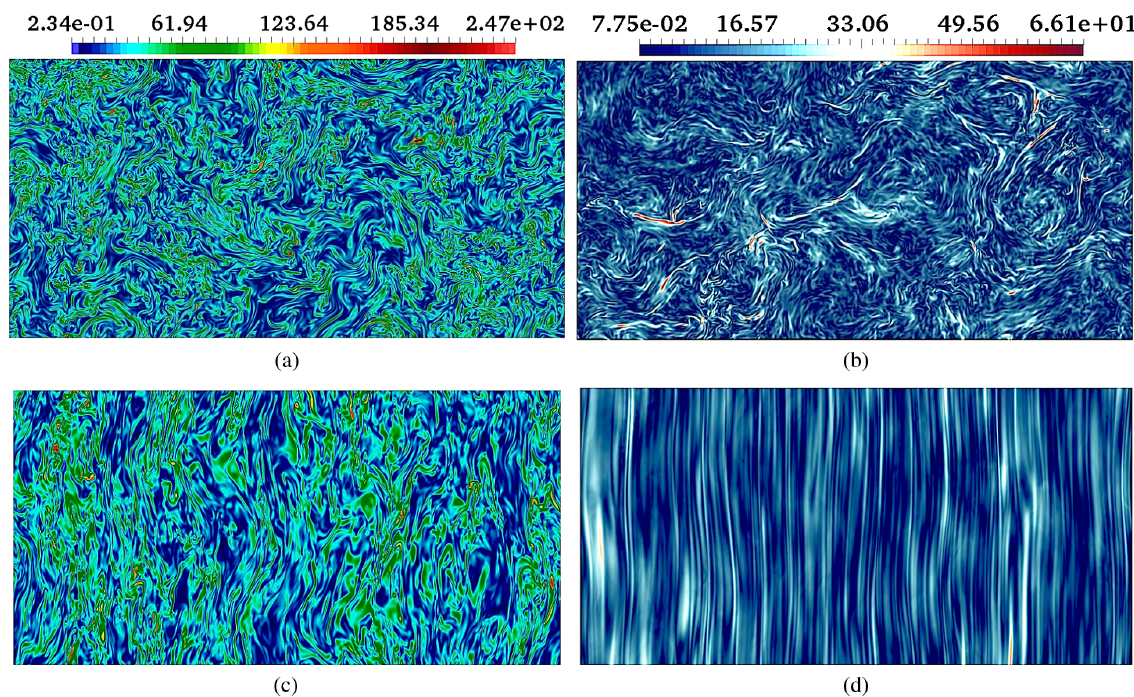
FIG. 4. Amplitude of vorticity (left panels) and current density (right panels) fluctuations in a field-perpendicular (top panels) and field-parallel (bottom panels) cross section of the simulation domain (run I). Clearly, the anisotropy is stronger for the current density than the vorticity fluctuations. The width of the snapshots is equal to 2 × d i and the height to 1 × d i .